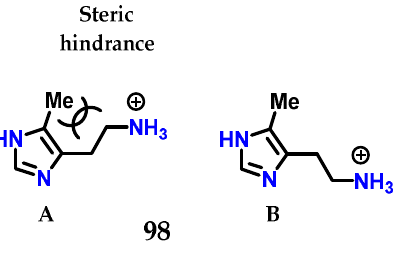
Figure 40. Conformations of 4(5)-methylhistamine 98 . Energetically unfavorable conformation A and the more stable conformation B .